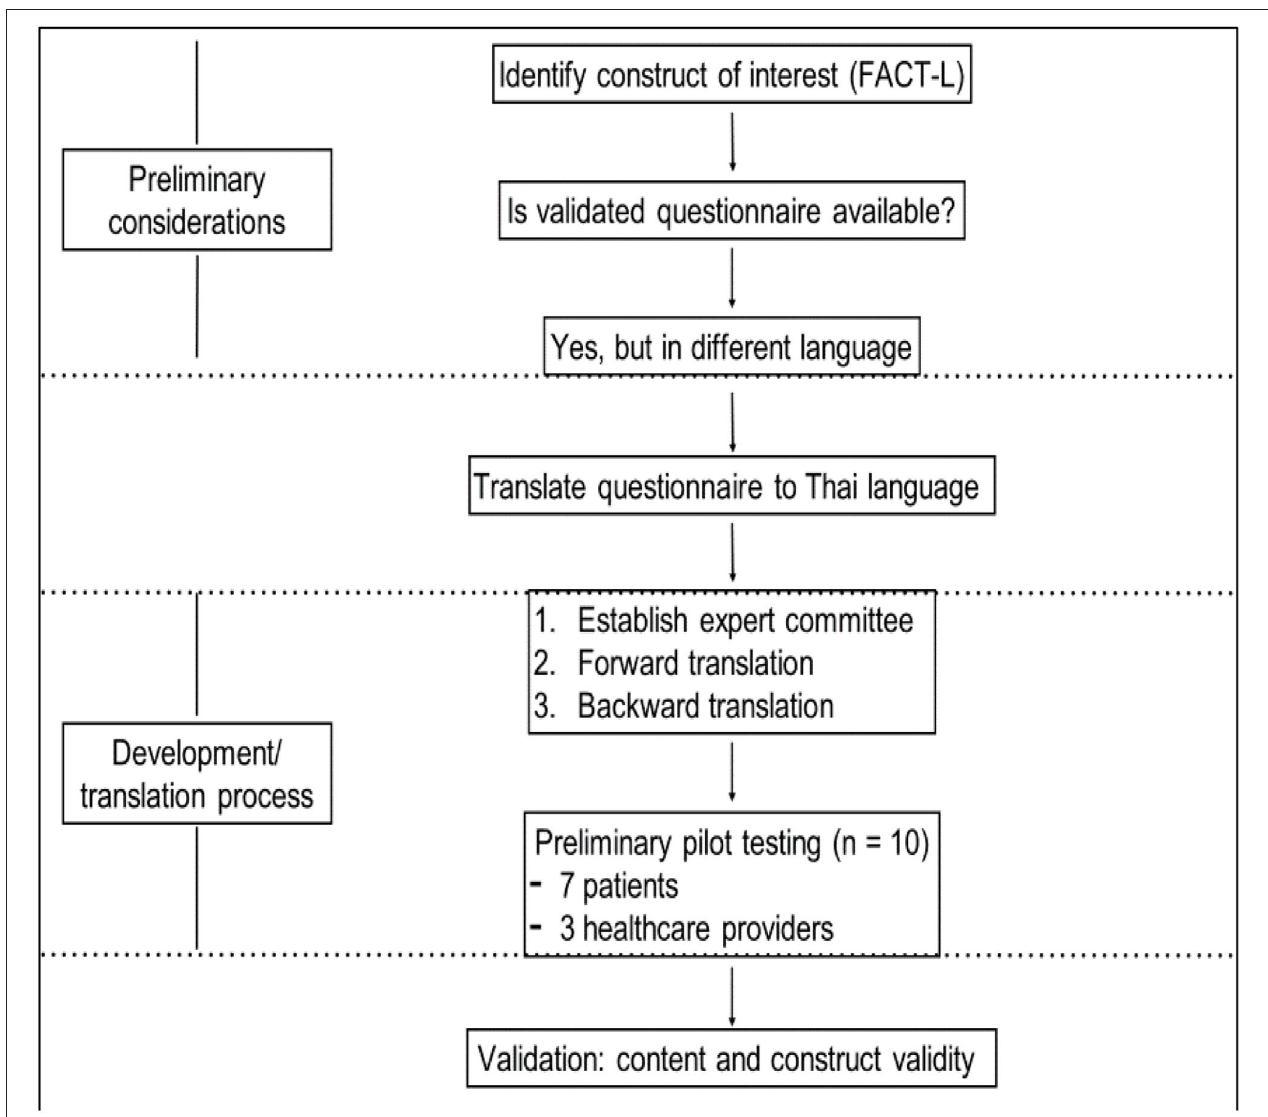
FIGURE 3 | The tool development and translation